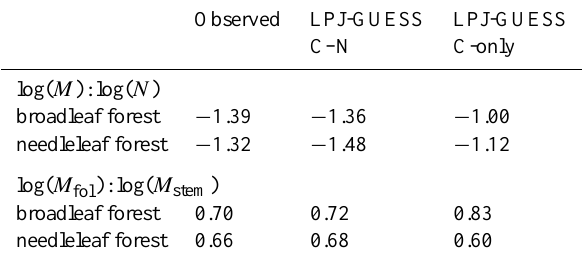
Table 2. Slope ( β ) of the scaling relationships depicted in Fig. 5 for observed forest stands and for the C–N and C-only simulations. For symbols see caption of Fig.